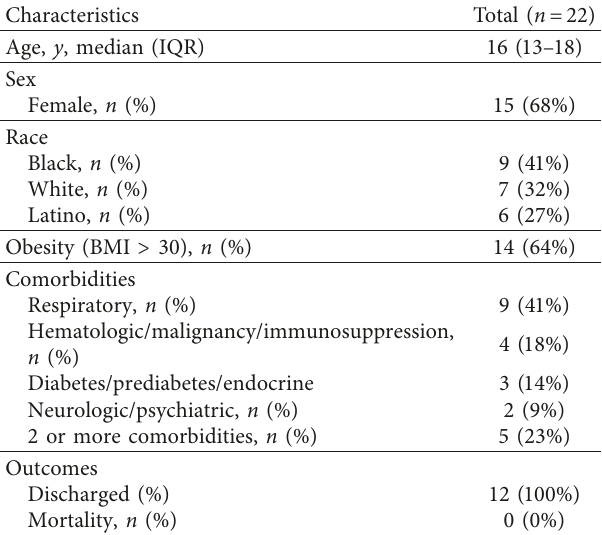
Table 4: Subgroup analysis: Characteristics of patients admitted postvaccination